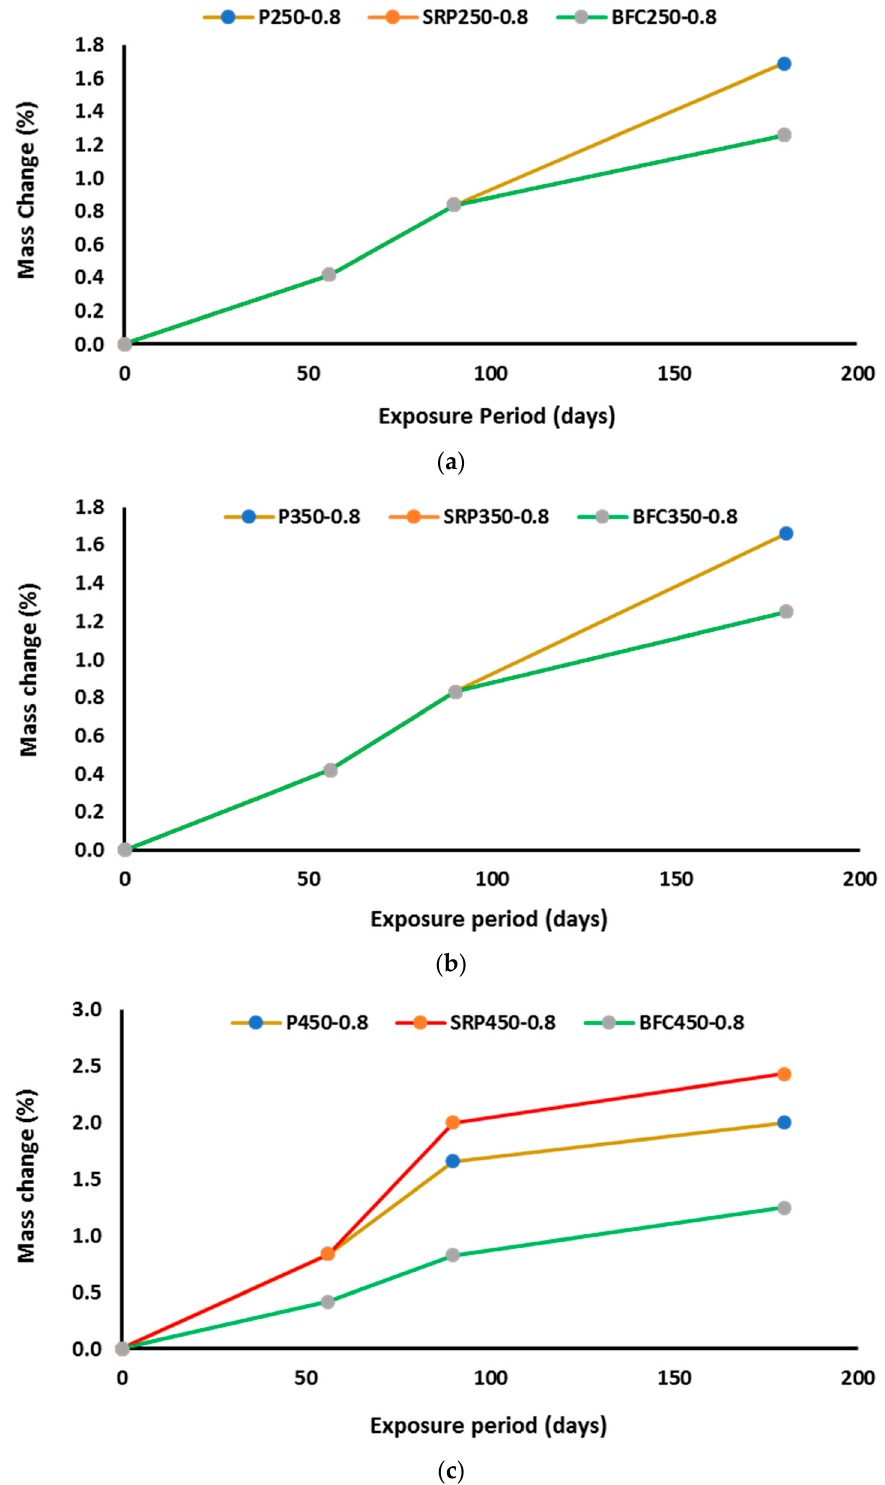
Figure 8. Mass change for mixes with high w/b ratios: ( a ) low strength concrete, ( b ) medium strength concrete, and ( c ) high strength concrete.